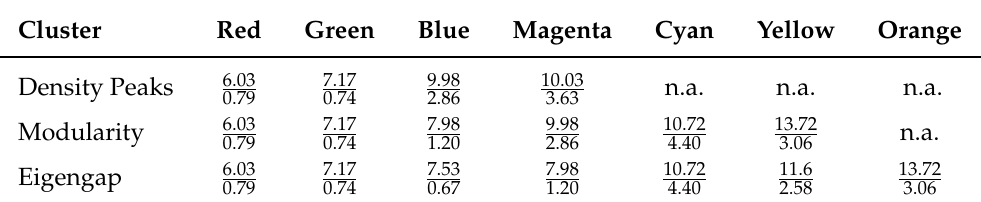
Table 1. Average speed values (m/s) over standard deviation (average speed/standard deviation) for a time period t = 6 with number of clusters K = 4 in the case of density peaks, K = 6 in the case of the modularity method and K = 7 in the case of eigengap.